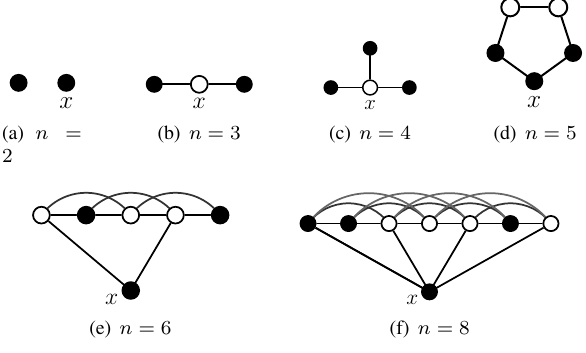
Fig. 1: A graph G where γ ( G x ) − γ ( G ) is maximal for small orders n . Black dots are codewords of an optimal identifying code in G .